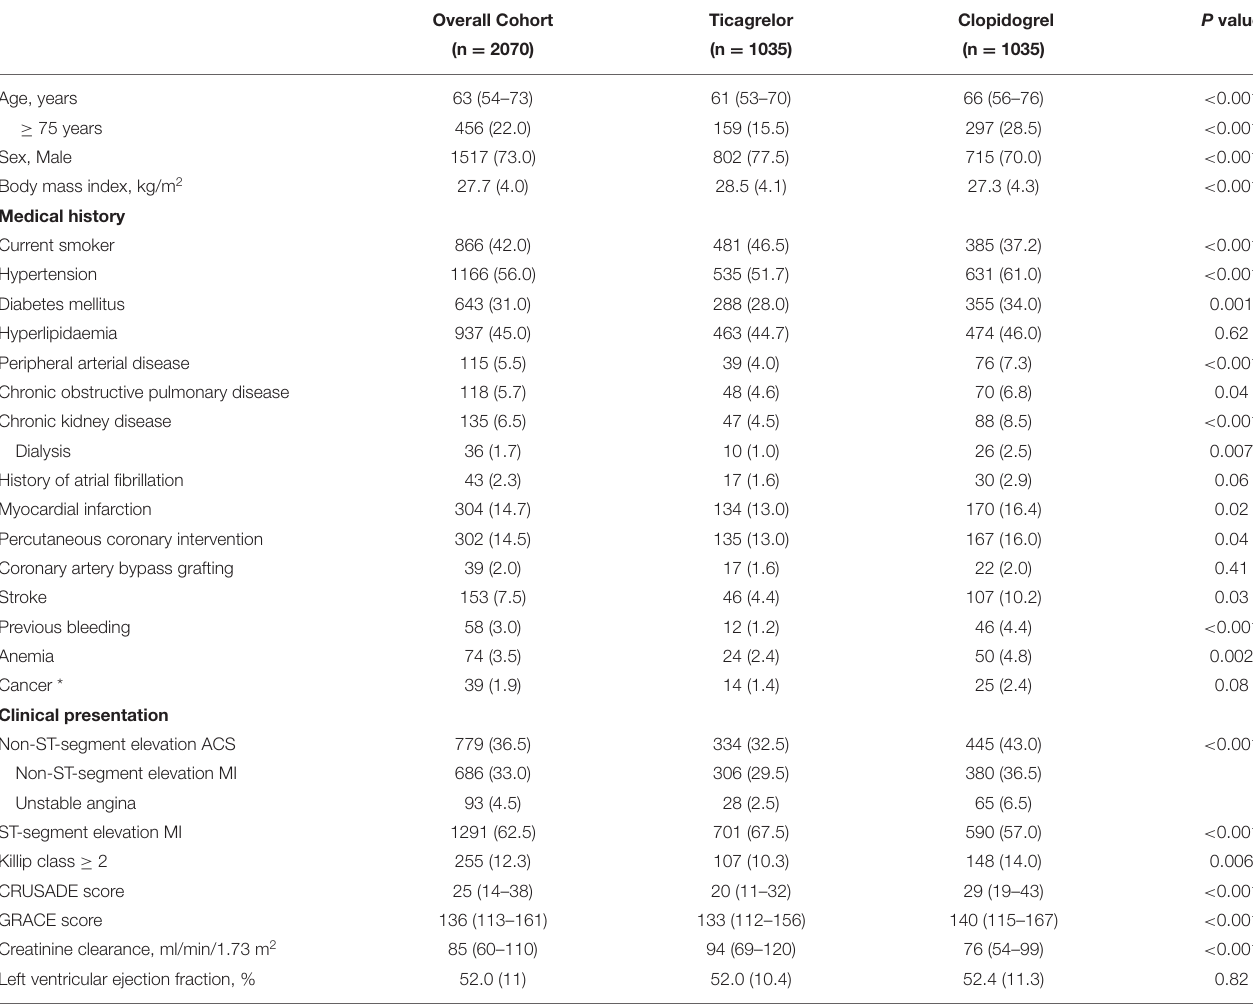
TABLE 1 | Baseline characteristics of patients according to the P2Y 12 inhibitor prescribed at hospital